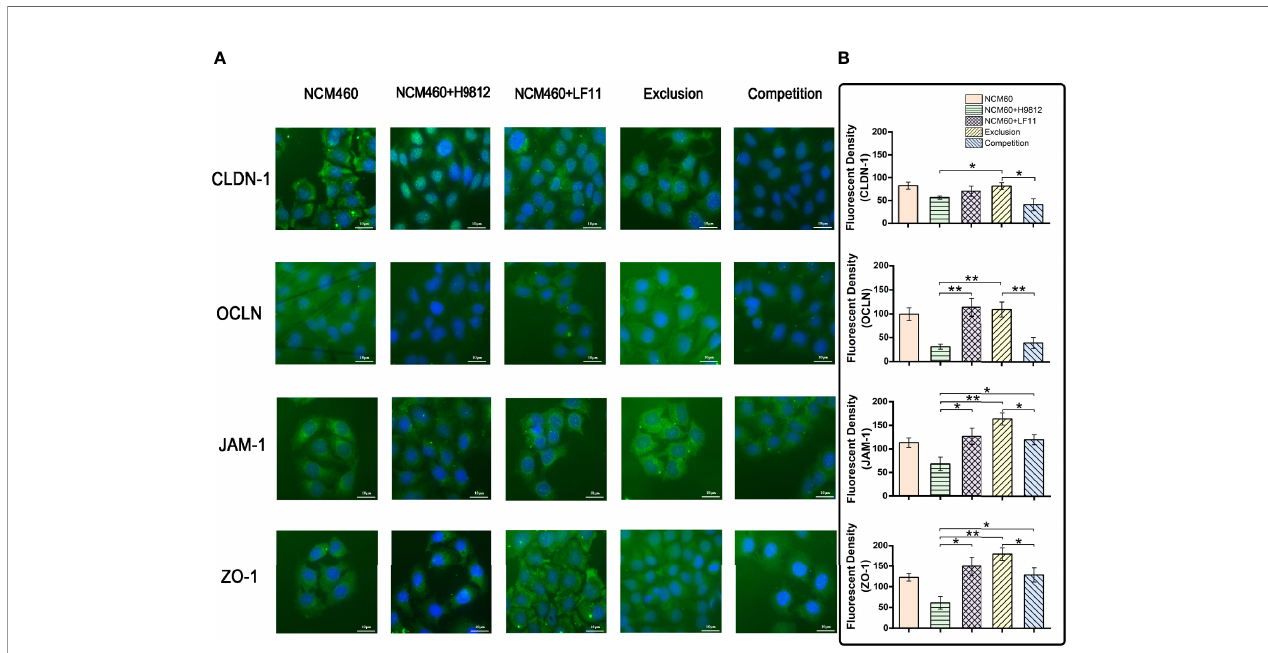
FIGURE 4 | The immuno fl uorescence analysis of tight junction proteins in NCM460 cells. (A) Expression levels and distribution of these tight junction proteins in NCM460 cells with various treatments are visualized by immunostaining fl uorescein isothiocyanate (FITC, green). Nuclei are counterstained using 40,6-Diamidino-2- phenylindole dihydrochloride (DAPI, blue). (B) Quantitative analysis of fl uorescence density was carried out using ImageJ. Statistical analysis is performed with Student ’ s t -test. Scale bar = 10 m m. * p < 0.05, ** p <